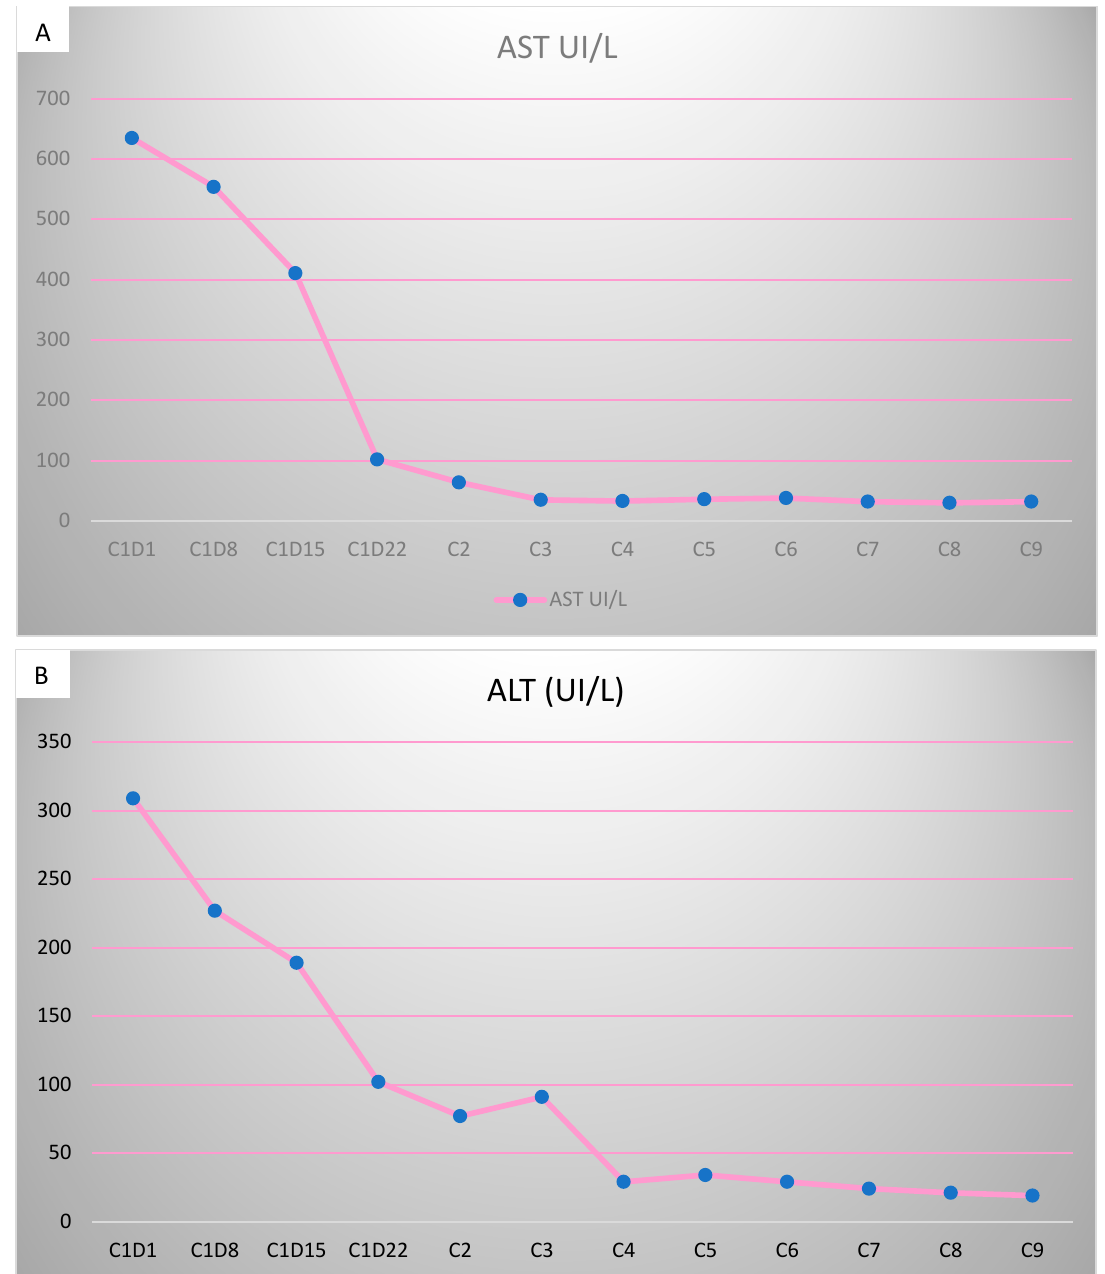
Figure 4. ( A ) Pretreatment CT scan of the lungs showing interlobular septal thickening and multiple bilateral peribronchovascular nodular opacities. ( B ) CT scan showing resolution of interlobular sep- tal thickening and remission of most of the pulmonary nodules after treatment with six cycles of Pertuzumab, Trastuzumab and Paclitaxel.